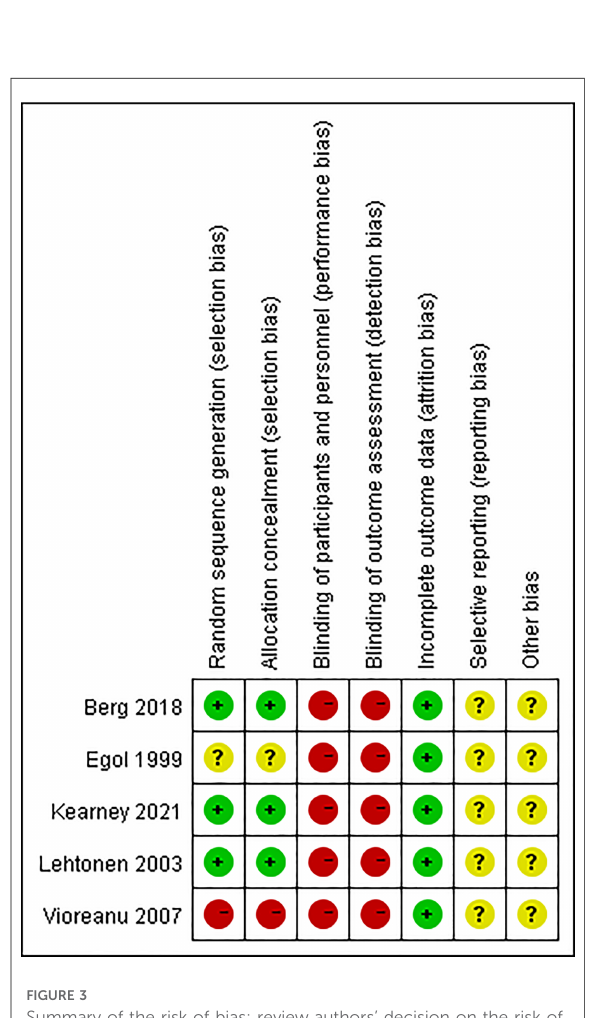
FIGURE 3 Summary of the risk of bias: review authors ’ decision on the risk of bias item one by one for every included